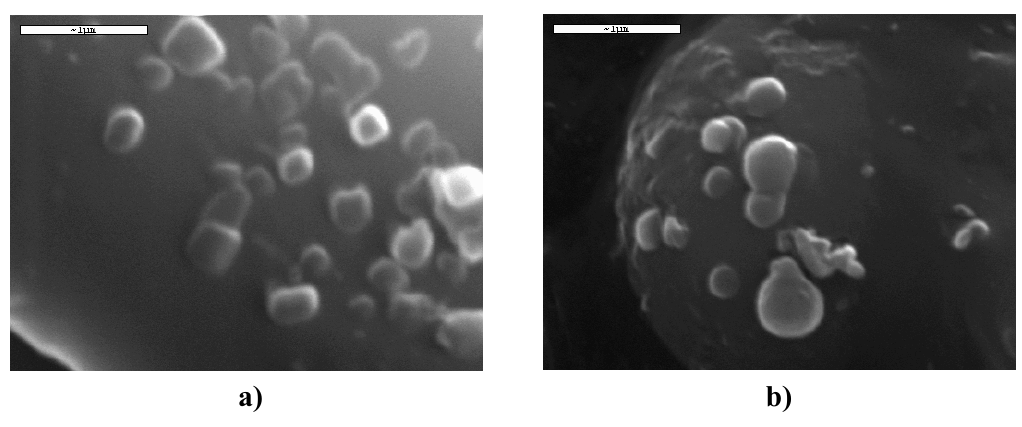
Figure 8. SEM micrographs of the Raloxifene loaded a) P(ESu-co-PAd) 70/30 copolymer and b) PPAd,